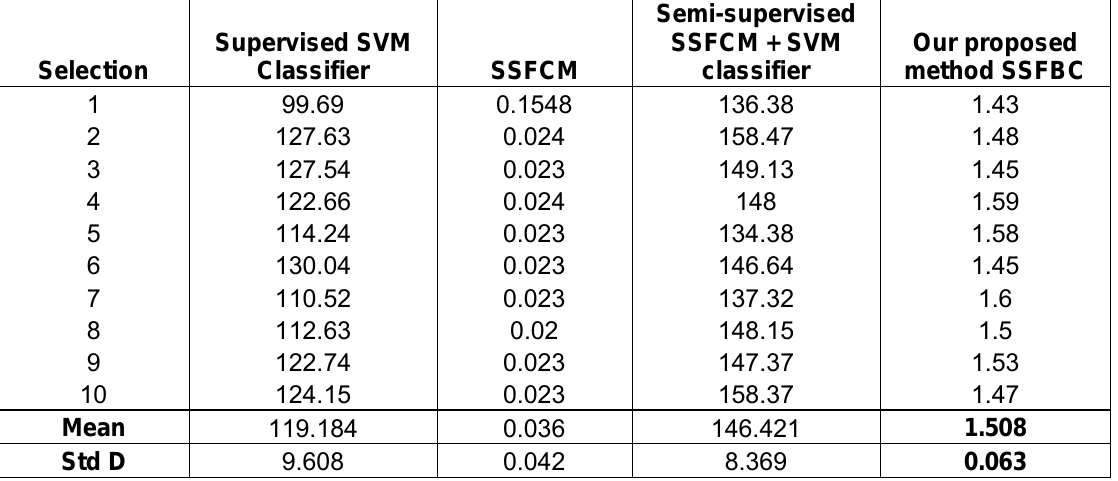
Table 5. Computational time spent for labelling Wireless Indoor Localization